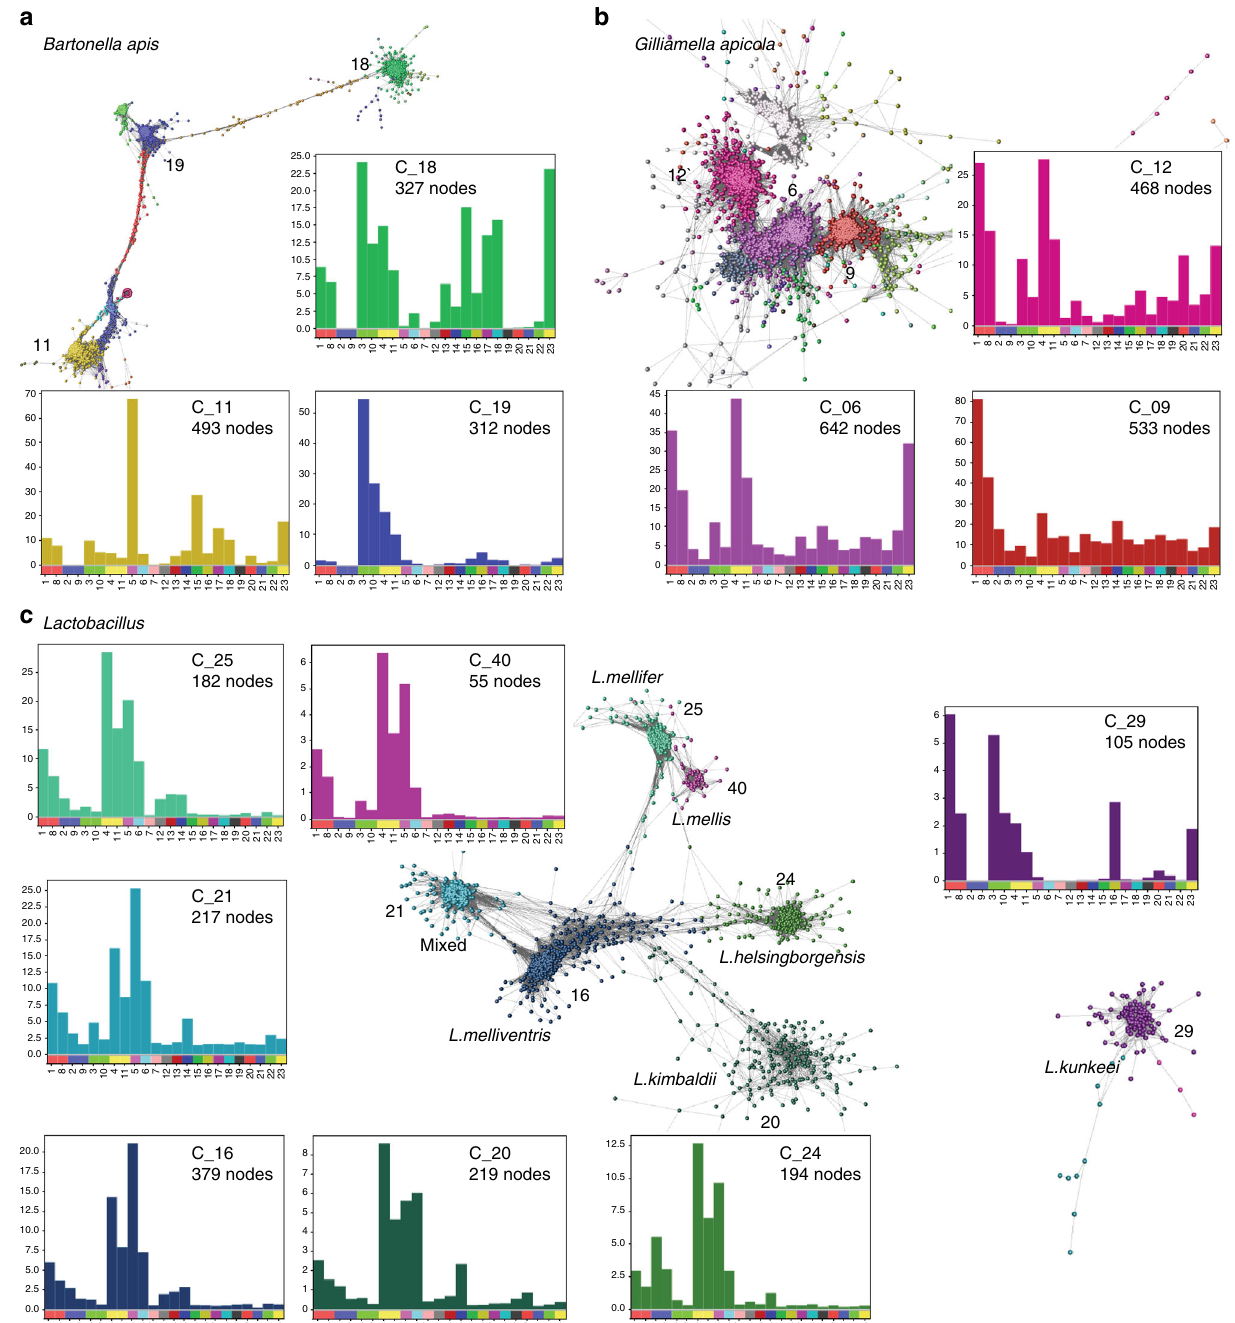
Fig. 5 Communities of honey bee cobionts. Sub-networks of contig clusters from Fig. 3 coloured by cluster. Histograms show the mean base coverage per contig ( y -axis) for each sample ( x -axis). The number of contigs (nodes) in each cluster is also given. a Bartonella apis , b Gilliamella apicola and c several Lactobacillus species. Blobplots describing the taxonomy and cumulative span for each of these panels are presented in Supplementary Figure 3a –